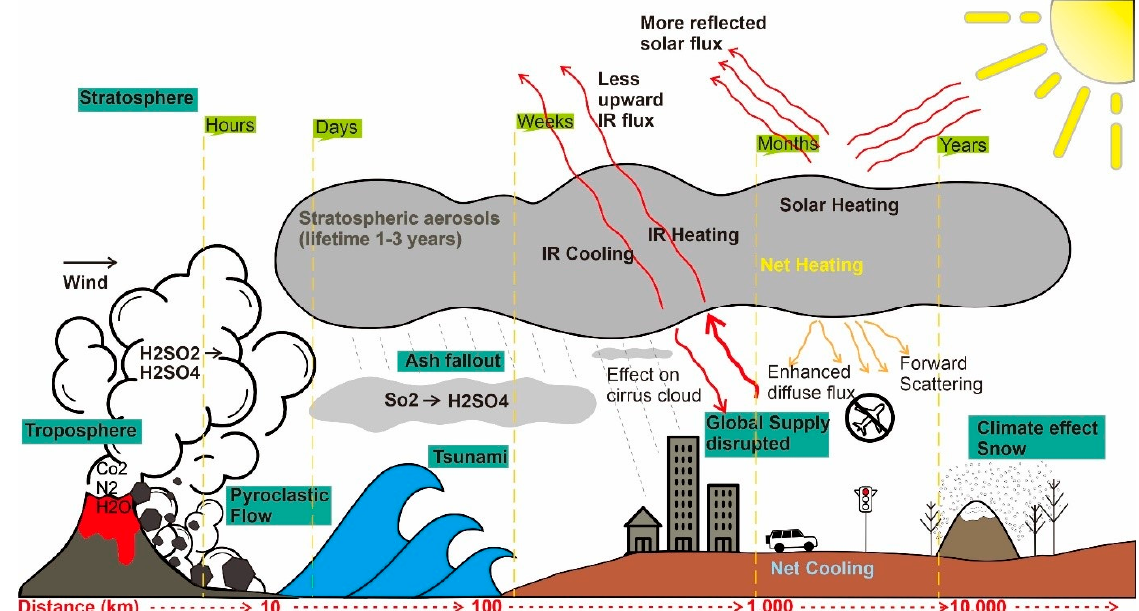
Figure 5. Short term and long term effects of a large volcanic eruption on the atmosphere and the environment (modified from Ref. [70,74]).